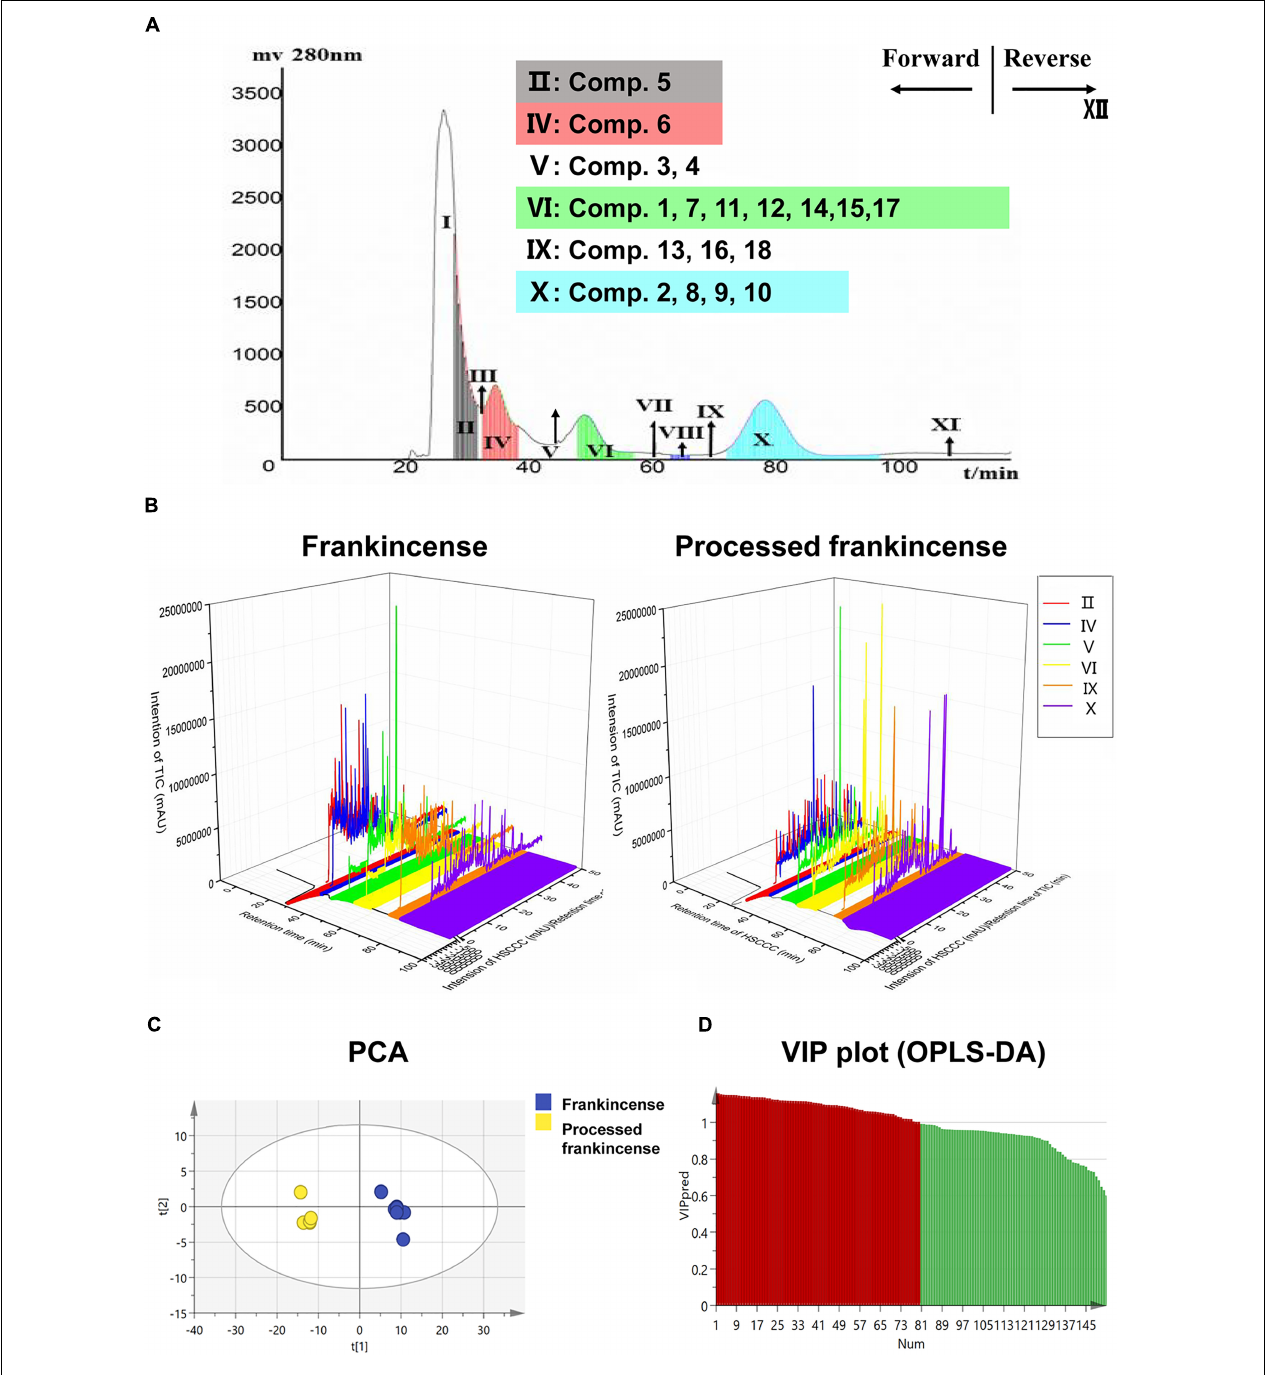
FIGURE 1 | Metabolomics research of frankincense and processed frankincense. (A) The application of HSCCC for partial analysis for a larger lab-scale preparation. (B) Information extension of the HSCCC and UHPLC-Qtof-MS combination. (C) PCA score plots of frankincense and processed frankincense. (D) Variable importance plot (VIP) of the OPLS-DA model between frankincense and processed frankincense.